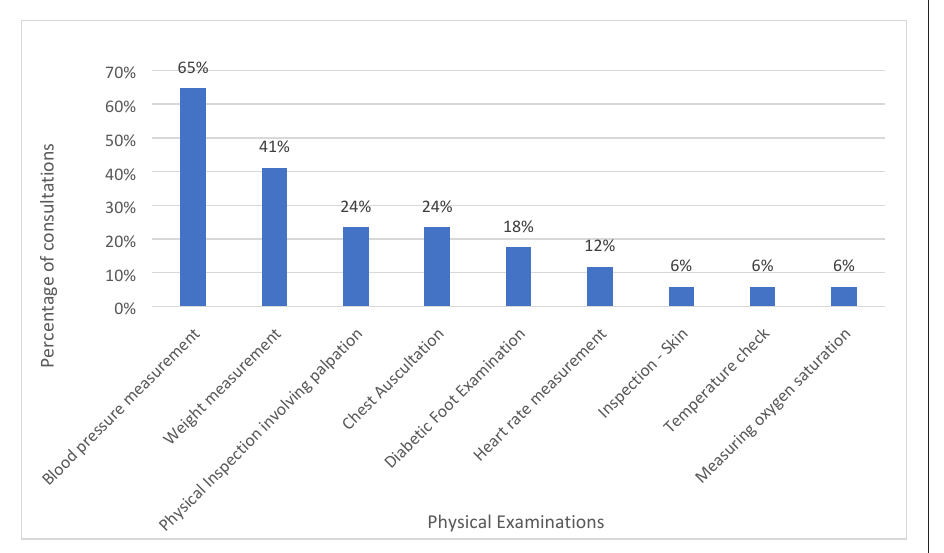
Figure 1: Frequency of physical examinations performed during in-person consultations, as a percentage of total consultations (n =